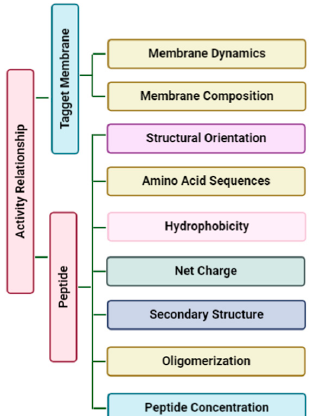
Figure 3. Physicochemical considerations that may impact structure-activity. These factors decide how effectively peptides burrow into the phospholipid bilayer. Membrane dynamics and membrane composition of the target membrane can affect the interaction with the amphipathic peptide.